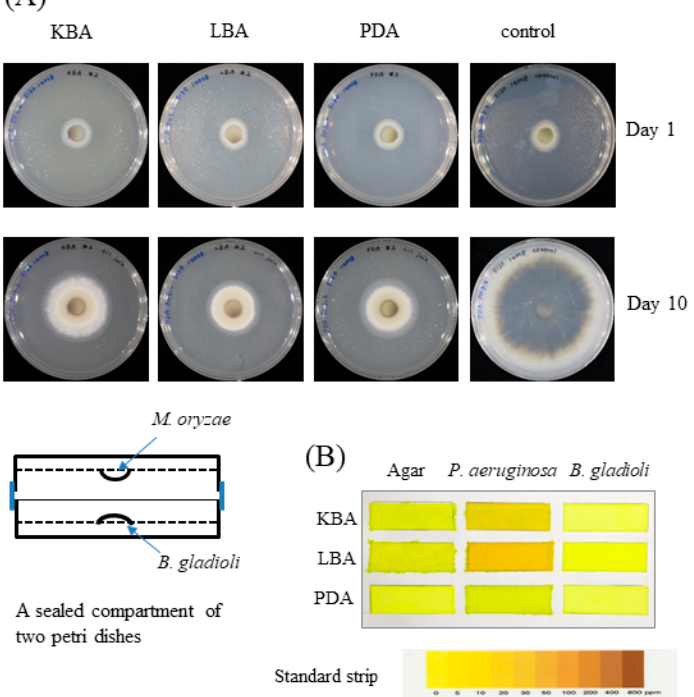
Figure 5. Inhibition of M. oryzae by B. gladioli BBB-01 via fumigation. ( A ) M. oryzae and B. gladioli BBB-01 were cultivated separately on two agar plates within a sealed compartment as illustrated. M. oryzae was grown on PDA, while B. gladioli BBB-01 was grown on KBA, LBA, or PDA as indicated. The growth of M. oryzae alone was taken as the control. The radial colony of M. oryzae on days 0 and 10 after fumigation was shown. ( B ) P. aeruginosa and B. gladioli BBB-01 were cultivated on KBA, LBA, or PDA. A paper strip soaked with picric acid and sodium carbonate was stuck on the lid within the sealed petri dish. The appearance of brown color of the paper indicates the presence of hydrogen cyanide as indicated by the standard strip.